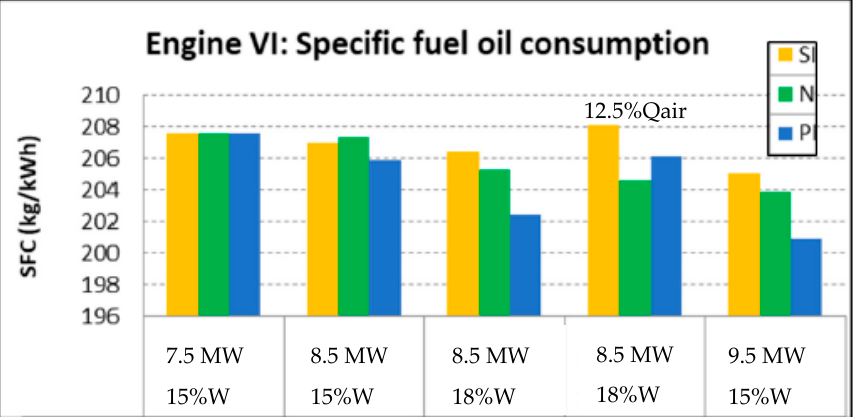
Figure 20. Determination of specific fuel oil consumption in systems S, P, N.